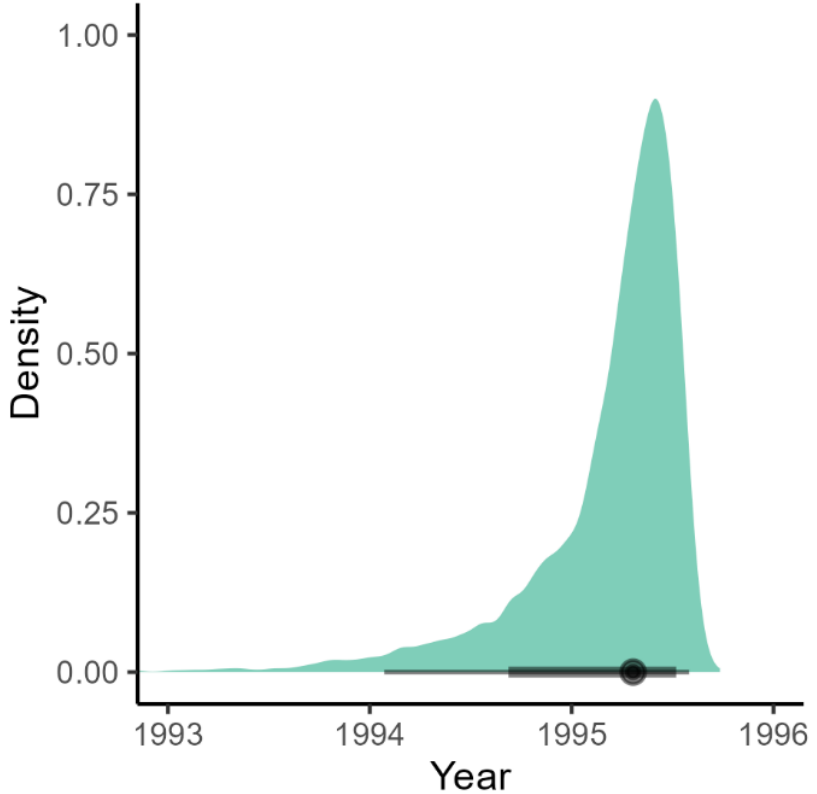
Figure 3. Density plot of the estimated age of the root of the RHDV1 phylogenetic tree based on the Bayesian Skyline Plot analysis. The dot on the black bar shows the posterior median, the thick bar the 80%, and the thin bar the 95% credible intervals.